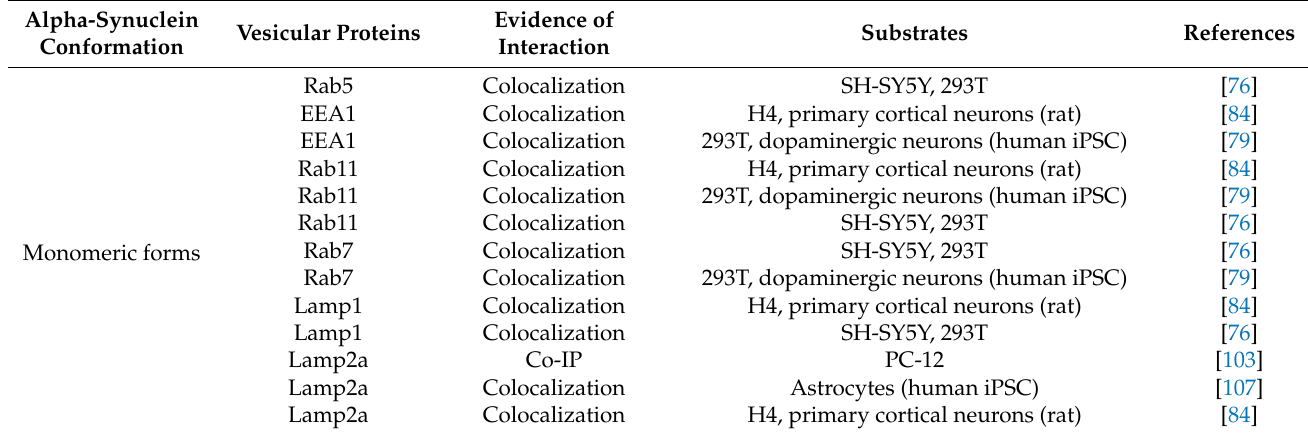
Table 1. Interactions between alpha-synuclein and main vesicular